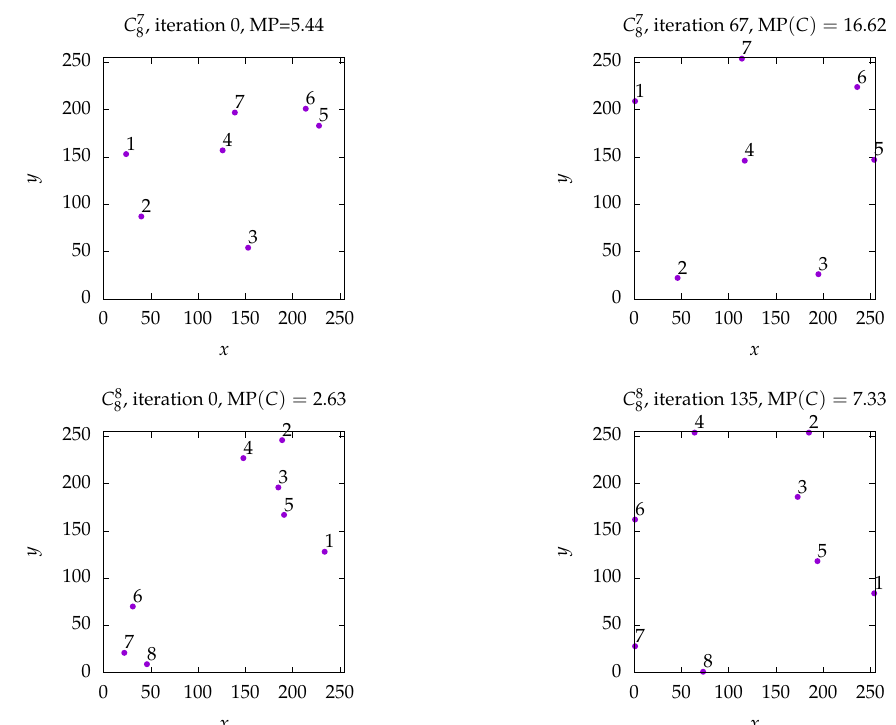
Figure 8. Two OT instances with improved MP value, one per row. To the left the initial set of points and to the right the set of points after applying Algorithm 1. Note how the set of points tend to cover most of the available space.